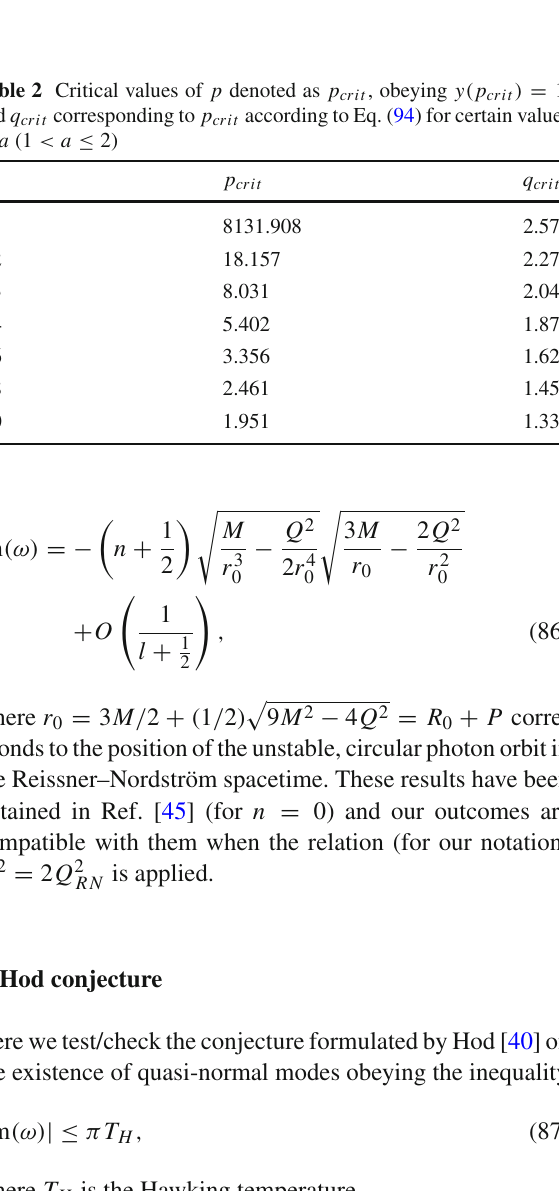
Fig. 4 The dependence of y on p for different a (see (88)) in the range 0 < a ≤ 1. Left panel: two dimensional plot in logarithmic scale. Right panel: three dimensional plot